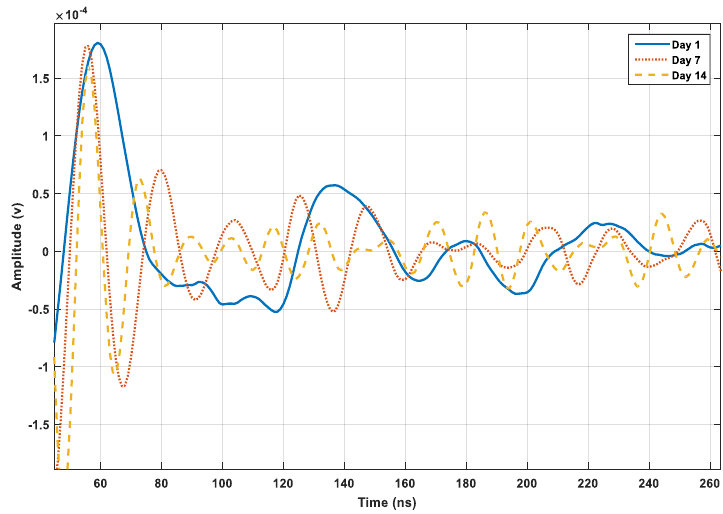
Figure 6. Raw signals amplitude variation on days 1, 7, and 14.